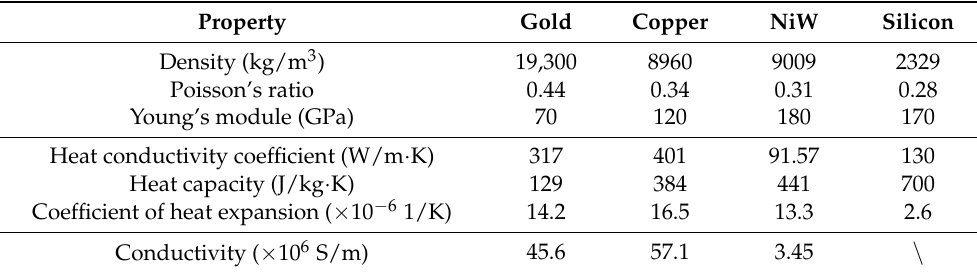
( b ) Figure 5. Schematic views of the ( a ) deformed CMI and ( b ) vertical displacement distribution. The models of two materials, copper and gold-plated NiW, were simulated and are compared in Figure 6. The maximum stress of the model with copper is about 1.01 GPa, which exceeds the yield strength of copper and can lead to a heavy plastic deformation or even cracks. However, with the implementation of gold-plated NiW, the maximum stress is about 1.66 GPa, which is still within the range of yield strength of NiW. It is worth noting that the oxidation and corrosion would shorten the lifetime of ambient-exposed CMI. To resolve this issue, the method of gold coating proposed in [11] was applied in